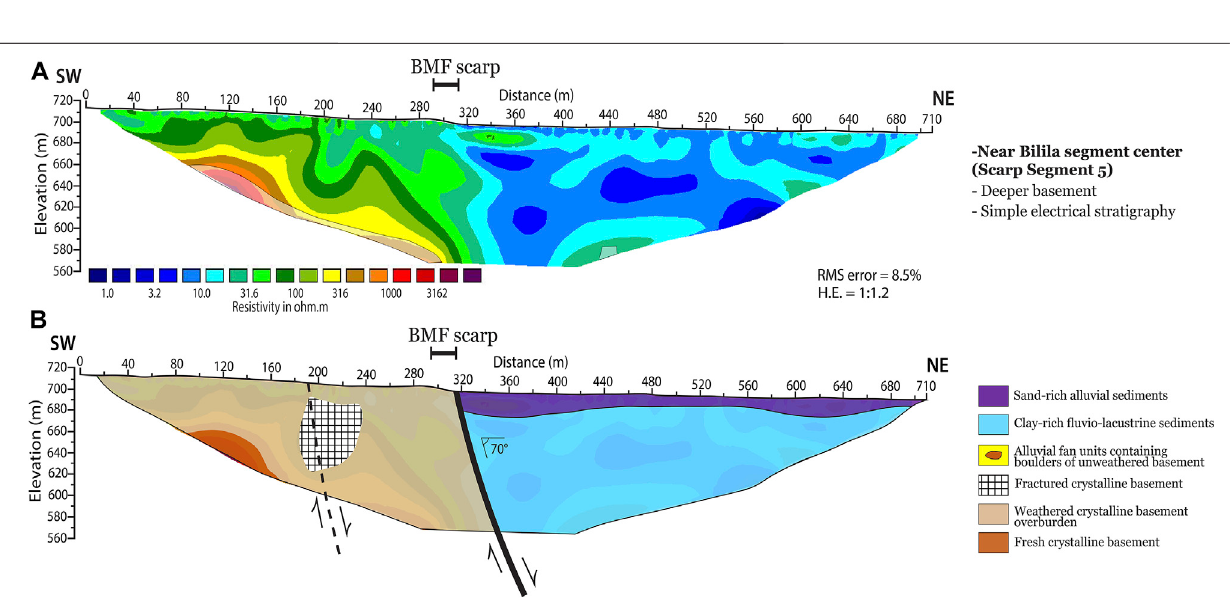
Frontiers in Earth Science |